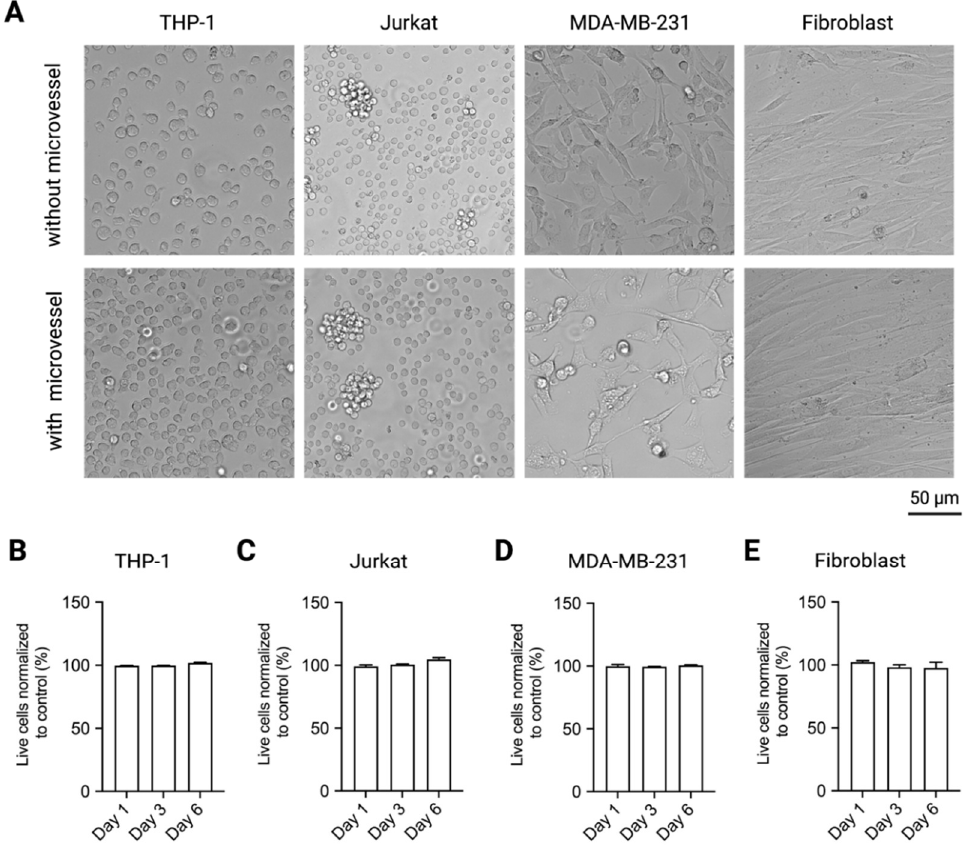
Figure 6. Long-term effects of microvessel on cell culture. ( A ) Images of cells cultured with and without microvessels for 6 days. Long-term viability of ( B ) THP-1, ( C ) Jurkat, ( D ) MDA-MB-231 and ( E ) Fibroblast cells cultured with microvessels for 1 day, 3 days and 6 days. Data are presented as mean ± SD. Experiments were performed in at least 4 replicates.